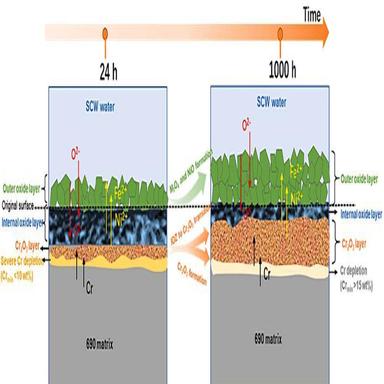
Illustration of the transition from internal to external oxidation at the early 24 h and its evolution with the increase in oxidation time to 1000 h.